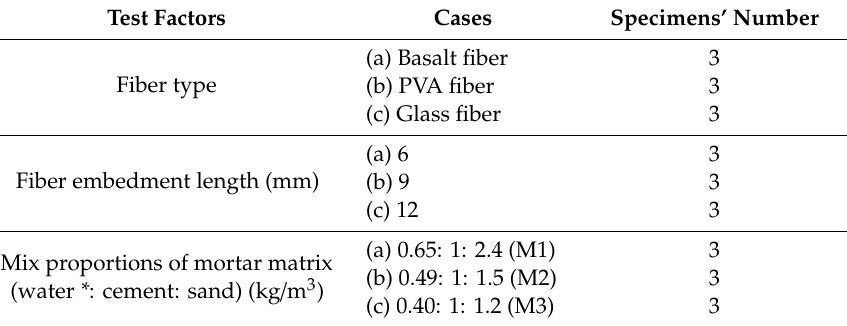
Figure 1. Three types of fiber: ( a ) basalt fiber, ( b ) polyvinyl alcohol (PVA) fiber, and ( c ) glass fiber. Three di ff erent strengths of mortar matrix were investigated, referred to as M1, M2, and M3, all of which were produced using di ff erent mix proportions as listed in Table 1. Specifically, the water to cement ratio (W / C) of M1, M2 and M3 is 0.65, 0.49 and 0.40, respectively. Table 1. The work scope of the pull-out test